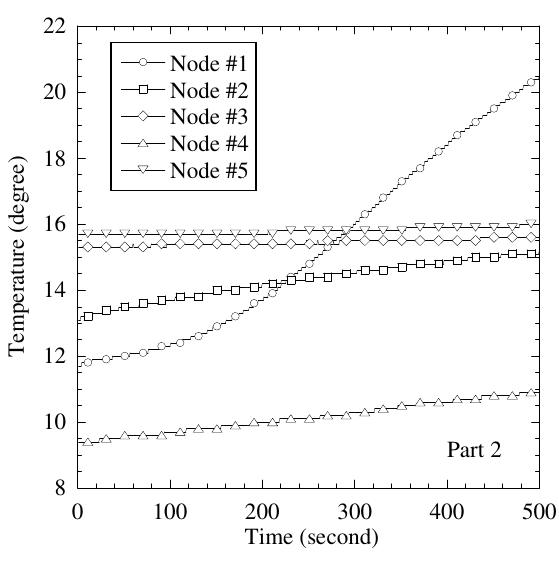
Figure 12. Results of temperature sensor in Part 2.